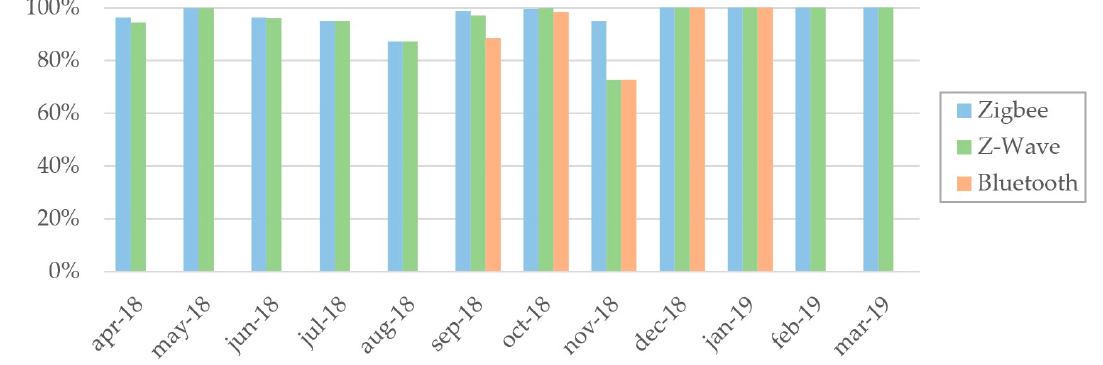
Figure 10. Availability of each deployed technology. Table 2. Availability of each deployed technology in a one-year